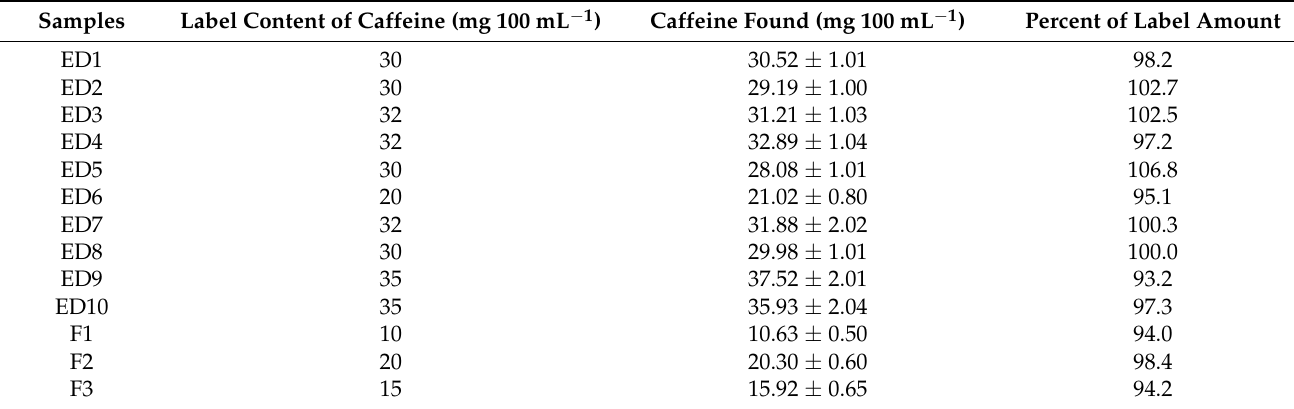
Table 6. Determination of caffeine in different energy drinks (ED) and various commercial formula- tions using the green HPTLC method (mean ± SD; n = 3).